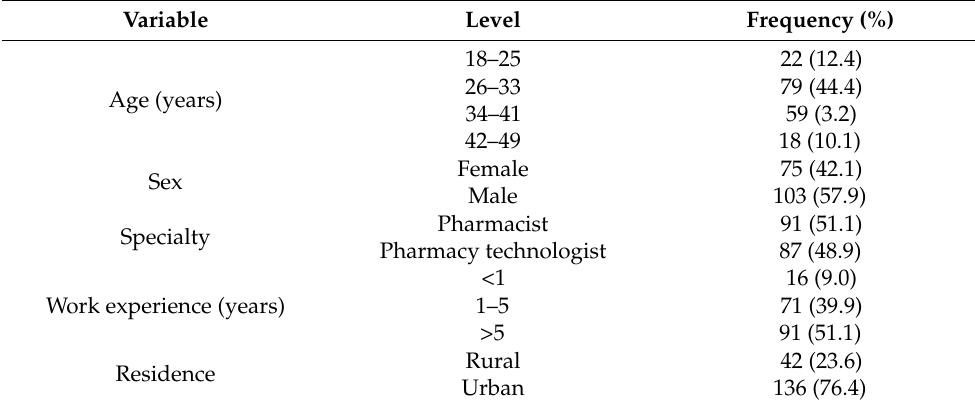
Table 1. Socio-demographic characteristics of study participants.